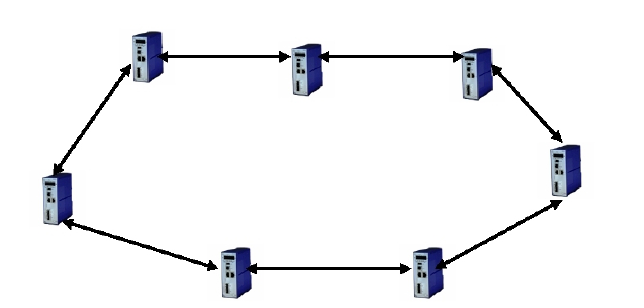
Figure 8. Bus network topology.